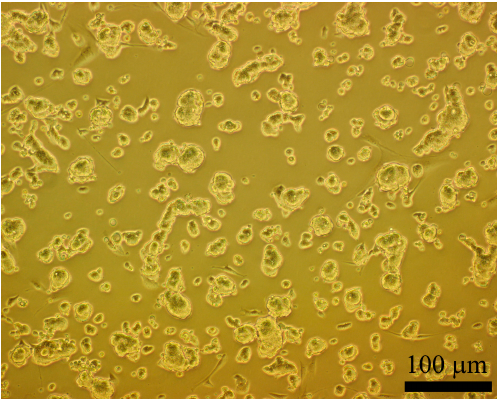
Figure 4. The Optical image of induced pluripotent stem cells (iPSCs) at passage-12. The iPSCs appeared as discrete clusters of variable sizes. The cell boarders were indistinct and difficult to resolve.